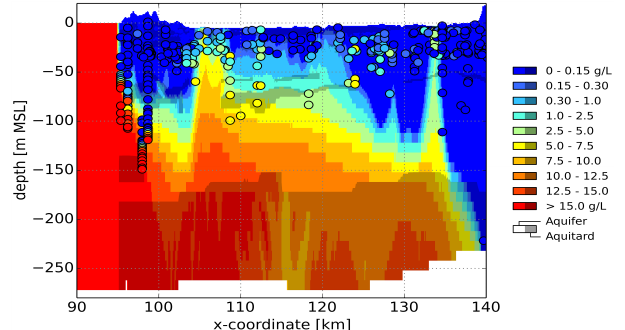
Figure 5. Chloride measurements versus modeled chloride concen- tration at AD2010. Measurements were selected within a trape- zoidal buffer (2km (b) at the surface to 5km at 300m depth) around and projected orthogonally onto the modeled